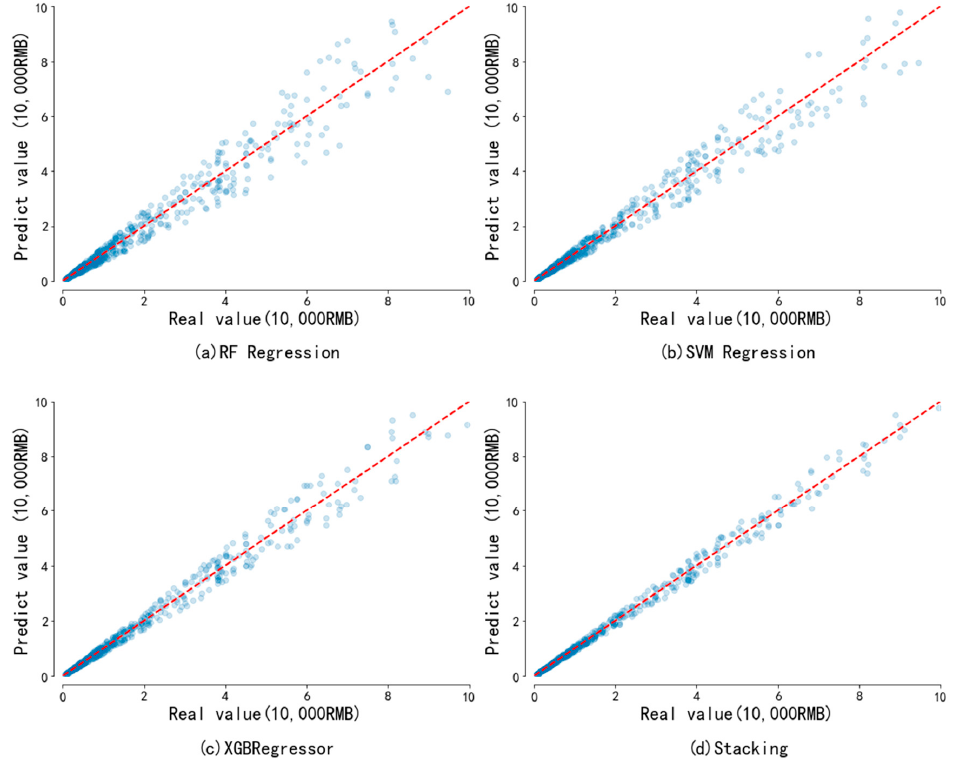
Figure 3. Comparison between predicted and real values for different